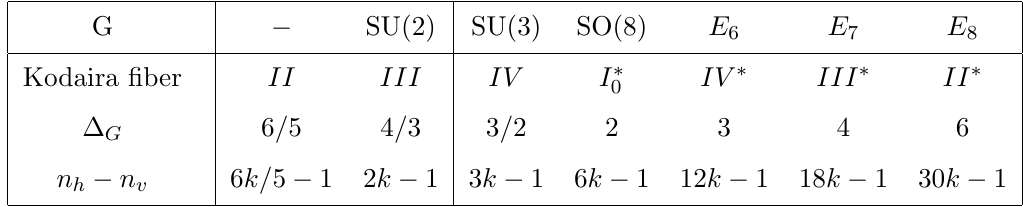
Table 2 . Properties of H ( k ) theories. The type of Kodaira (cid:12)ber associated to the H ( k ) G listed, as well as the scaling dimension (cid:1) G of the lowest dimensional Coulomb branch operator and the di(cid:11)erence between the e(cid:11)ective numbers of hyper and vector multiplets.